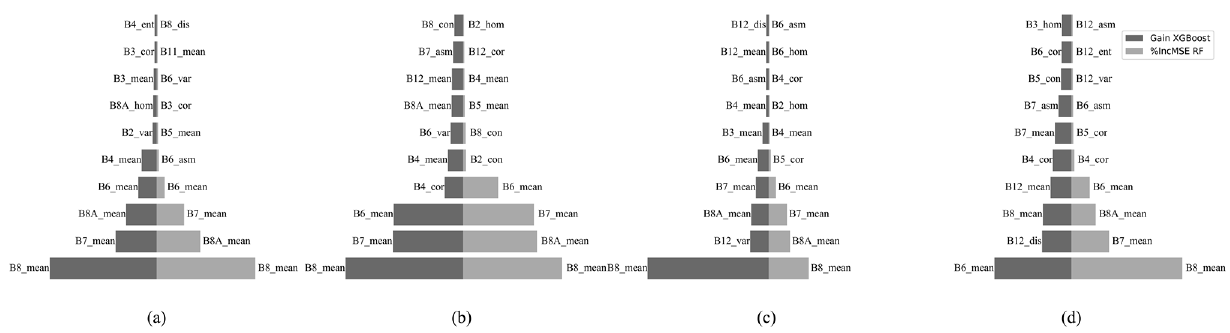
Figure 3. Variable importance of RF and XGBoost models for AGB estimation using analysis set 3 in four processing window sizes, ( a ) 3 × 3 window size, ( b ) 5 × 5 window size, ( c ) 7 × 7 window size, and ( d ) 9 × 9 window size.